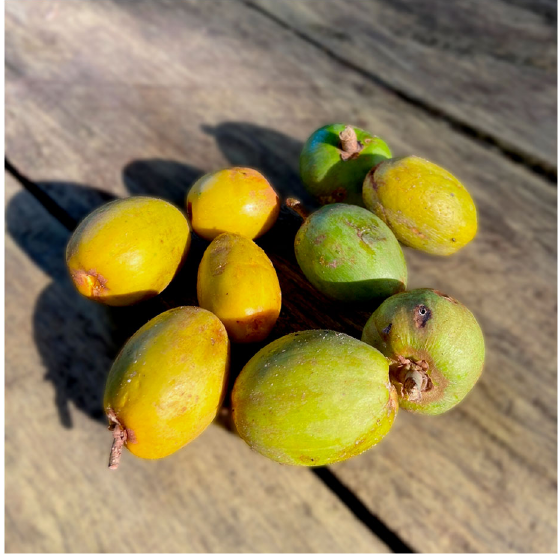
Figure 1. Pouteria macrophylla fruit (source: